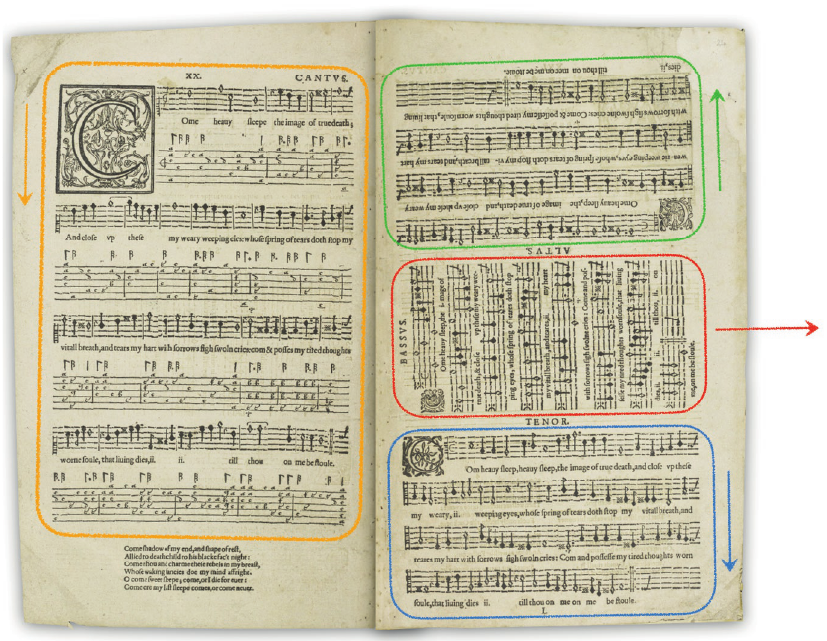
Fig. 1 John Dowland, “Come, heavy sleep” in The First Booke of Songes or Ayres (London: Peter Short, 1597), segn. L. The arrows shows the direction of reading for each